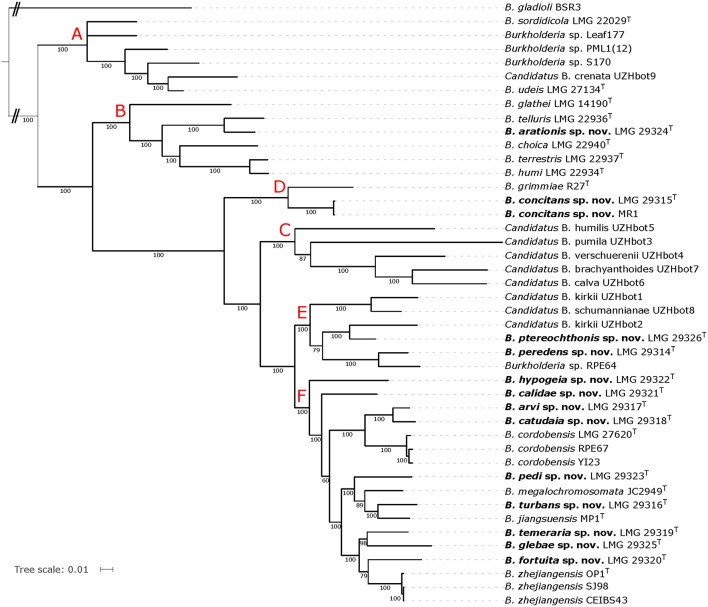
Whole-genome phylogeny based on single-copy orthologs of all BGC genomes. The phylogenetic tree was constructed using the WAG protein substitution model and RAxML and is based on an amino acid alignment with 105,141 positions from 332 single-copy orthologous genes. The percentage of replicate trees in which the associated taxa clustered together in the bootstrap test (100 replicates) are shown next to the branches if greater than 60%. B. gladioli BSR3 was used as outgroup. Red capital letters define subtrees that also occur in the tree depicted in Figure 2.